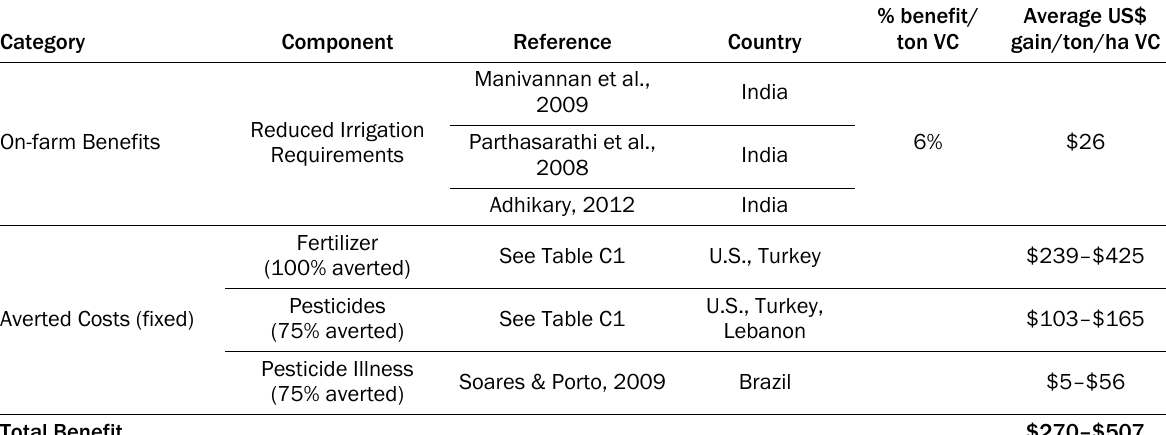
Table D1. Estimated Benefit/Ton/Hectare of Vermicompost (VC)